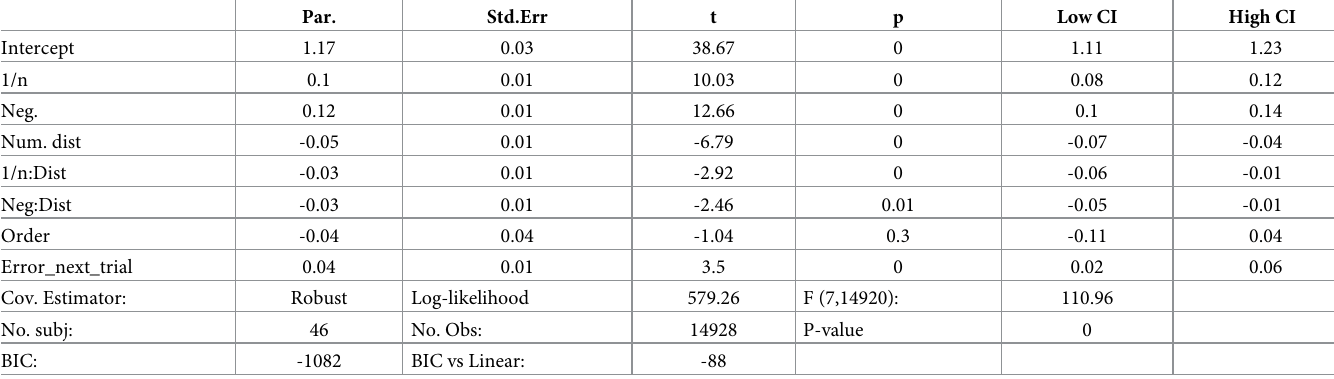
Table 2.4. RT. Exp. 2 . Random Effects Estimation.